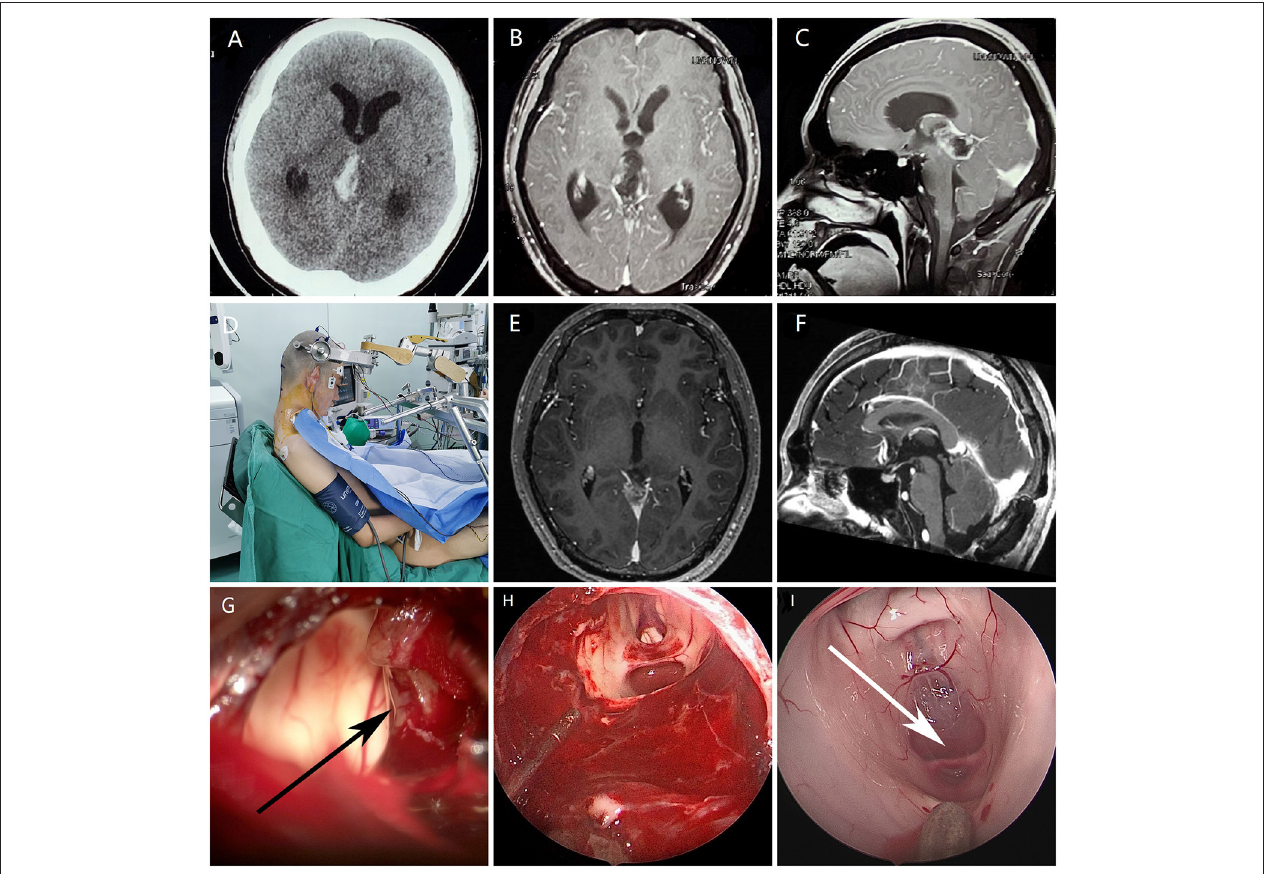
FIGURE 1 | Images of a patient with an ependymoma undergoing EAM. (A) Preoperative computed tomography showed a mass in the pineal region with bleeding (B,C) Preoperative axial and sagittal magnetic resonance imaging showed a pineal region tumor and obstruction of the cerebral aqueduct. (D) Sitting position with the head maximally flexed. (E,F) Postoperative magnetic resonance imaging showed complete resection of the tumor and remission of obstructive hydrocephalus at 1 month postoperatively. (G) The tumor (black arrow) and bleeding were observed under microscopy. (H) Resection of residual tumor by endoscopic surgery. (I) Entrance of the aqueduct (white arrow) under